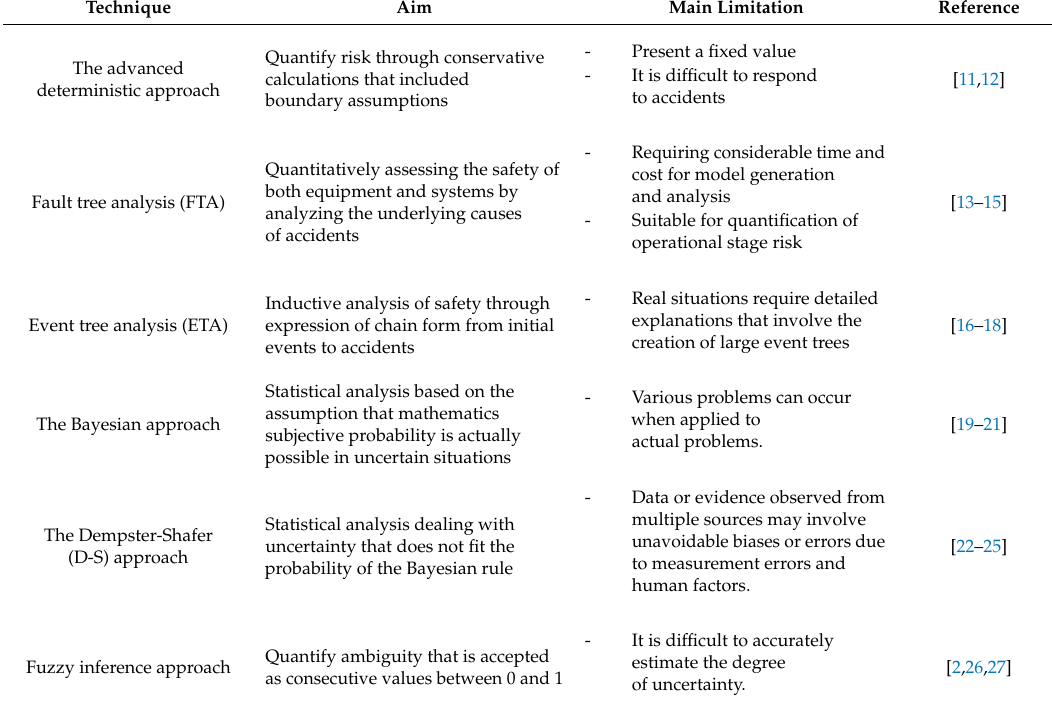
Table 1. The most frequently used applications of risk-related techniques in nuclear power plant